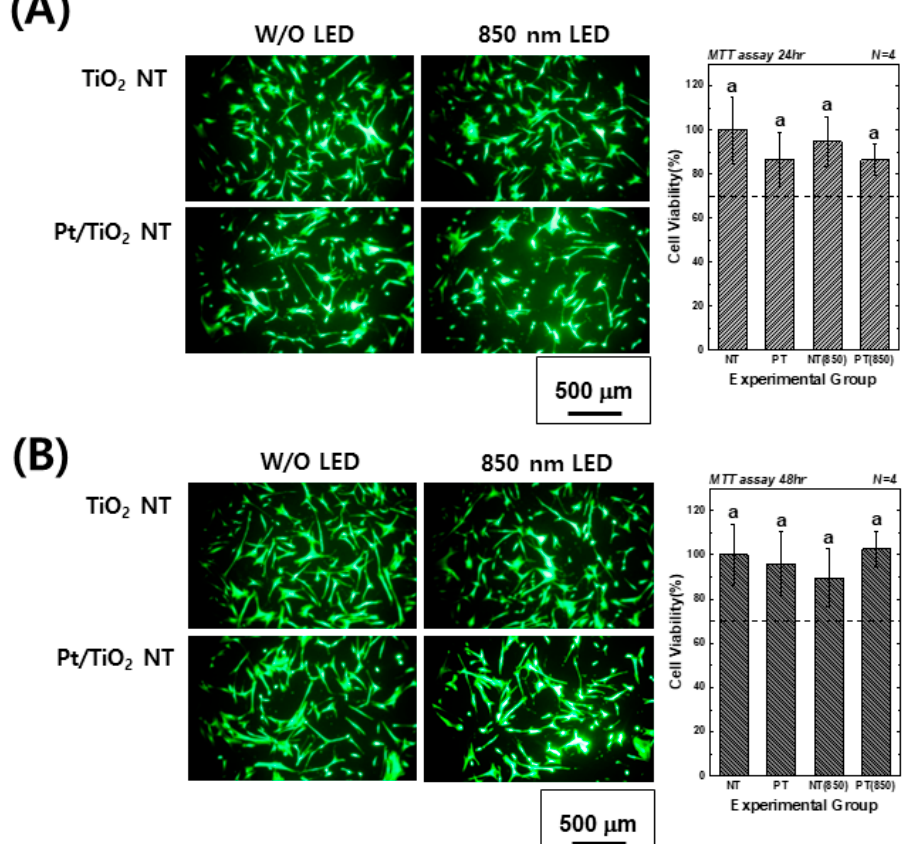
Figure 4. Calcein-AM- and EthD-1-stained images and MTT assay results of hMSCs cultured on TiO 2 NT and Pt-TiO 2 NT after ( A ) 24 and ( B ) 48 h of incubation (In each graph, the experimental groups with different letters indicate statistical significance by one-way ANOVA at α = 0.05).